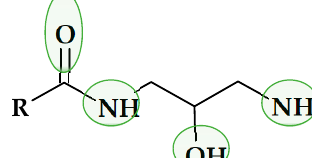
Figure 1. A likely hydrogen bond formation.